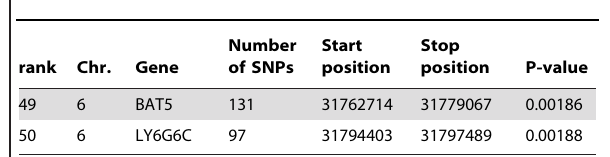
Table 2. Top 50 most associated genes with the EA in 9538